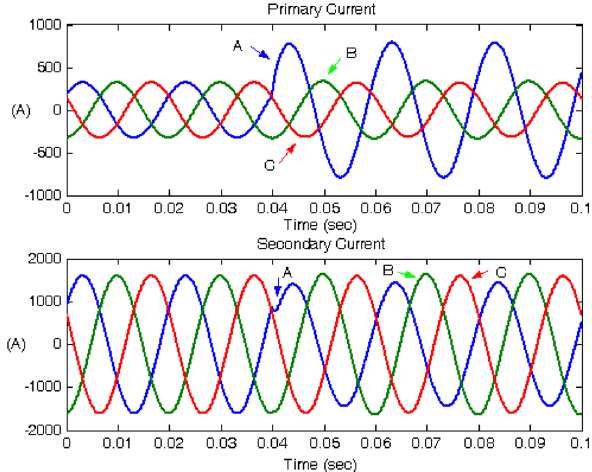
Figure 6. Primary and secondary currents under phase A winding-to-ground fault occurrence on the low- voltage winding at 10% of the length.